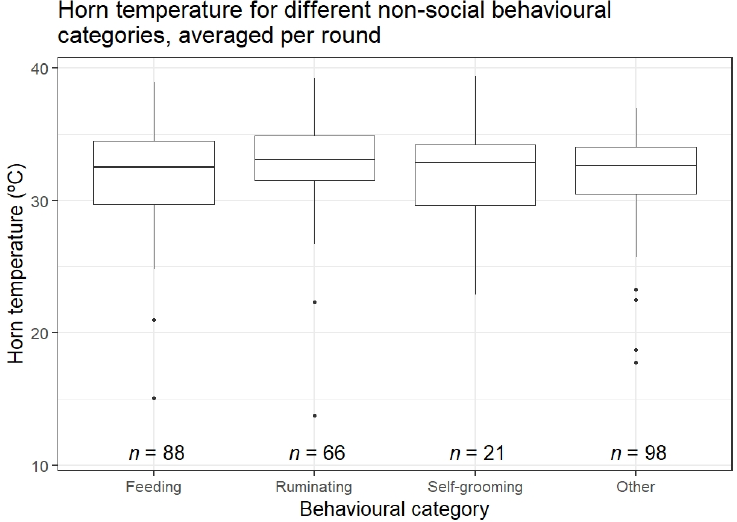
Figure 4. Horn temperature (averaged per round) during the different state behaviour categories.